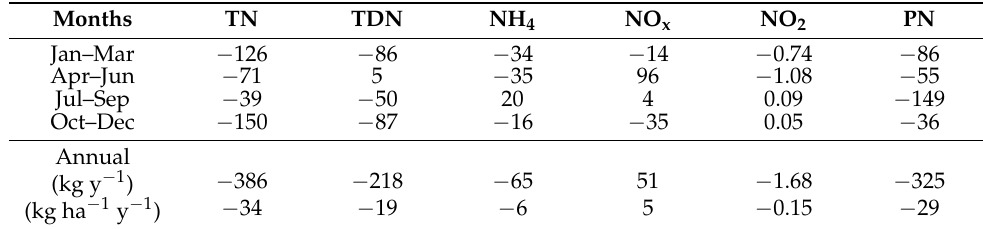
Table 4. Net quarterly (kg N/quarter) and annual (kg N/y) fluxes of all measured N constituents. Negative values represent tidal export. The total marsh area (11.22 ha) was used to normalize annual fluxes.